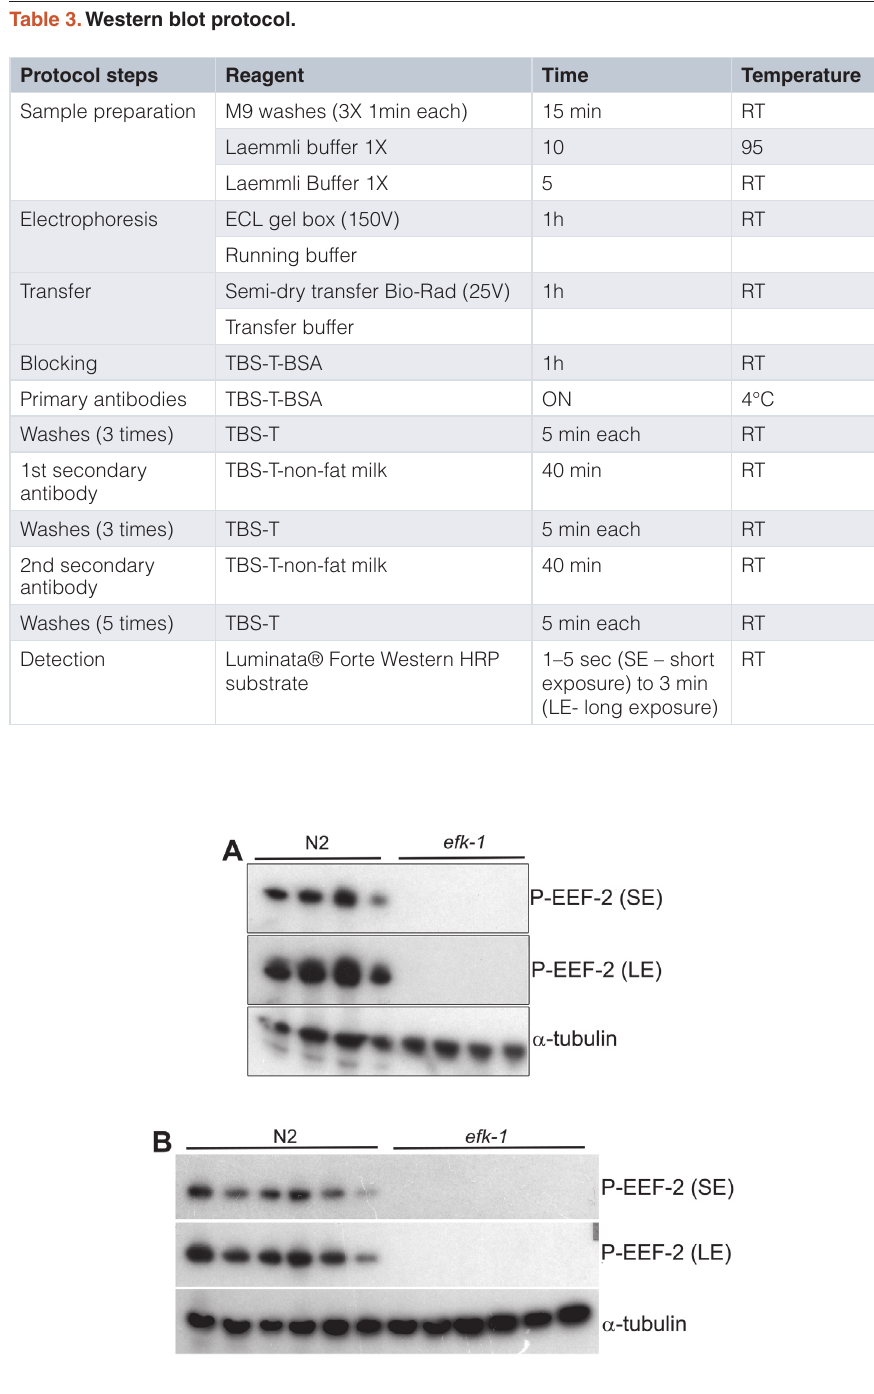
Figure 2. Phospho-eEF2 antibody specific to vertebrate eEF2 recognizes C. elegans phospho-EEF-2. Western blot showing that phospho-eEF2 antibody recognizes C. elegans (N2 Bristol) phospho-EEF-2, since protein detection signal is absent in efk-1 knockout worms. A ) phospho-EEF-2 detection at the first time antibody dilution in TBS-T-BSA. B ) phospho-EEF-2 detection after five freeze/thaw cycles of the antibody in TBS-T-BSA. SE- short exposure (5 sec); LE-long exposure (1